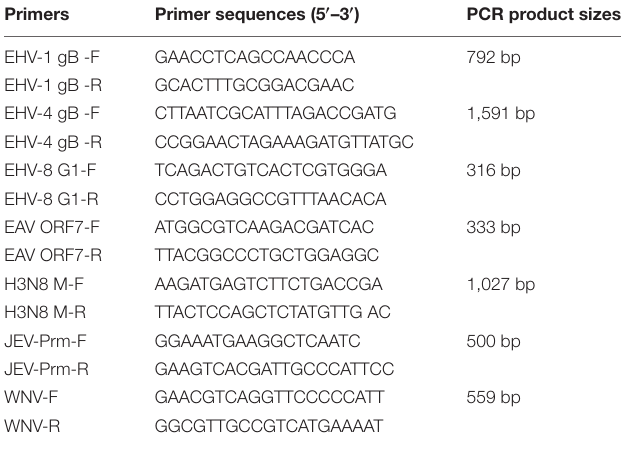
TABLE 1 | The primer sequences in this study. Primers